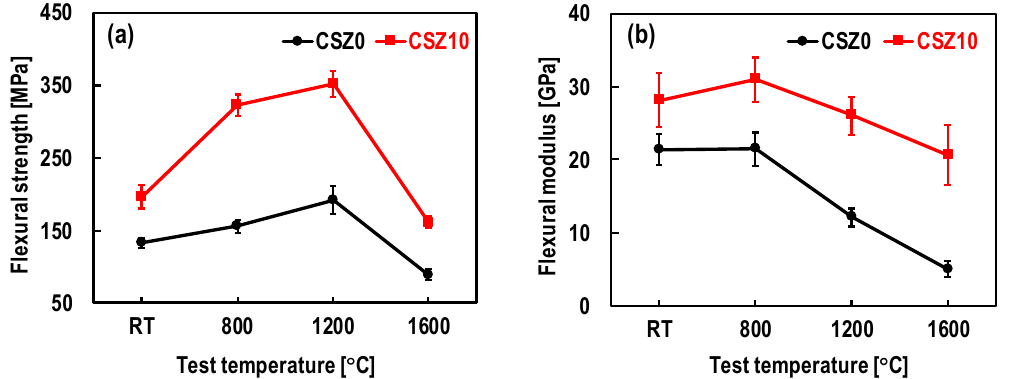
Figure 6. Mechanical properties as a function of temperature under vacuum: ( a ) the flexural strength; ( b ) the flexural modulus.